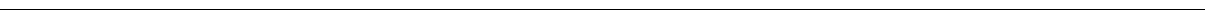
Fig. 4 Quadrant analyses reveal sub-populations of CM. a – c Quadrant analysis for Proliferation vs. Negative regulators of proliferation genes identi fi es increased co-expression in individual TAC nuclei (Q2; 44.4%; p = 3.237e − 07 Fisher ’ s exact test), only detectable by single nuclear RNA-seq ( a ), and not in pooled nuclei ( b ) or matched bulk left ventricle RNA-seq ( c ). Inset : histogram of nuclei distributed across quadrants. Blue represents Sham and red represents TAC nuclei. d – f Quadrant analysis for cardiac progenitor vs. cardiac transcription factor gene expression shows increased co-expression upon TAC stress in single CM nuclei d (Q2; 42.9%; p = 2.548e − 05 Fisher ’ s exact test), again not detectable in pooled nuclei or bulk tissue RNA-seq ( e , f ). g – i Increased co-expression of fetal reprogramming genes and dedifferentiation markers under TAC stress only detected in single nuclear RNA-seq ( g ) (Q2; 58.73%; p = 0.001371 Fisher ’ s exact test) and not in non-single approaches ( h , i ). j High co-expression of cardiac progenitors, cardiac transcription factors, dedifferentiation, proliferation, and negative proliferation markers is con fi ned to single nuclear TAC samples in Q2 and Q4. k , l Single molecule RNA FISH shows Sca1 upregulation and co-expression of Tnnt2 in isolated adult mouse CMs from TAC hearts l compared to Sham k . Number of Sca1 + Sham CMs: 5/13; Sca1 + TAC CMs: 38/55; all together from 2 Sham and 3 TAC biological replicates. m , n Immuno fl uorescence con fi rms increase in cell-surface SCA1 protein expression in TAC CMs ( n ) compared to Sham ( m ). Number of SCA1 + Sham CMs: 8/23; SCA1 + TAC CMs: 43/66; all together from 2 Sham and 3 TAC biological replicates. Scale bar represents 20 μ